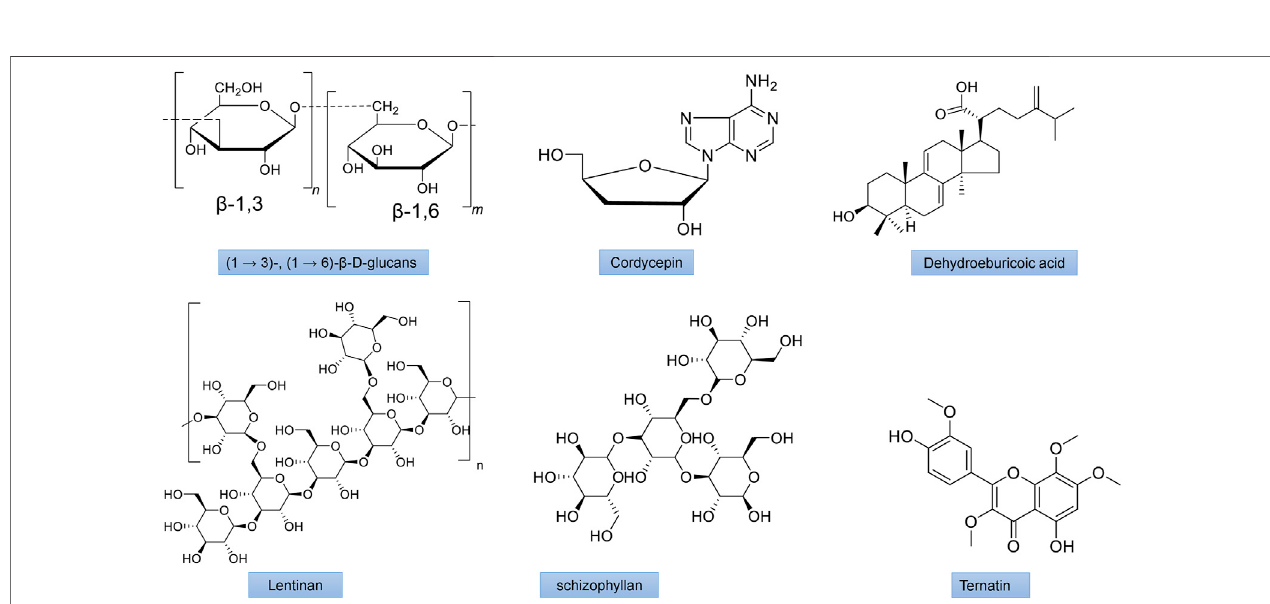
FIGURE 4 | The chemical structures of important mushroom antidiabetic activity compounds and polysaccharides. Ergosterol from Inonotus obliquus ; Ganodermic acidfrom Ganoderma lucidum; Grifolinfrom Grifola frondosa; Hispidinfrom Phellinus linteus ;Ergothioneinefrom Agaricusbisporus ; Inotodiolfrom Inonotus obliquus .